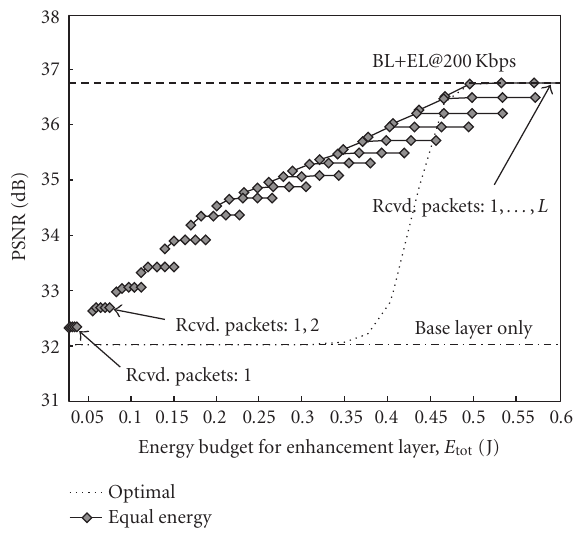
Figure 11: Comparison among di ff erent modulation schemes (BPSK, FSK, and MSK) in terms of PSNR at the receiver (RS(110,100), B T = 200KHz).